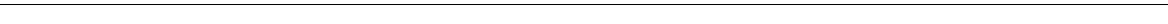
Figure 3 | Conformational dynamics in the GD-BSE region. ( a ) Histograms of FRET data from the mutant MxA MO2 -AS in different nucleotide-loading conditions. Error bars indicate s.d. of 1,000 bootstrap samples of the FRET traces. Decomposition of the FRET data resulted in two Gaussian curves representing distributions of a low-FRETstate (red) and a high-FRETstate (green). The number of molecules (N) of smFRET trajectories used to construct each histogram is displayed. ( b ) Crystal structures of stalkless MxA (left) and dynamin-1 (right) showing the corresponding distances in different nucleotide-loading forms. For MxA, apo (4P4U, green), GMPPCP-bound (4P4S, wheat) and GDP-bound (4P4T, cyan) forms are shown, and distances between amino acid residues 149 and 639 (634 is missing in these structural models) were measured. For dynamin, apo (3SNH, green), GMPPCP-bound (3ZYC, wheat), GDP (cid:2) AlF 4 (cid:3) -bound (2X2E, magenta) forms are shown, distances between residues 107 and 726 were measured according to the sequence alignment with MxA. ( c ) Fraction variation in the low-FRETopen state (red circle) and the high-FRETclosed state (green circle) during GTP hydrolysis. Two GTP hydrolysis cycles are depicted. ( d ) Representative fluorescence and FRET time traces with idealization (orange) in corresponding nucleotide-loading conditions. Here, FRET traces were idealized to a model containing four states corresponding to Gaussian decomposition shown in a . ( e ) TDPs in different nucleotide-loading conditions. Initial and final FRET (average FRET values before and after each transition respectively) were plotted as a 2D chart to indicate the transitions between the two distinct FRET states (scale at right). ( f ) Average dwell times in each FRET state in different nucleotide-loading conditions. Error bars indicate s.d. of 100 bootstrap samples. ( g ) Cross-correlation analysis shows enhanced dynamics for GMPPCP-loading condition while limited dynamics for the other three conditions. Error bars indicate s.d. of results from five independent experiments. 2D, two-dimensional; TDP, transition density